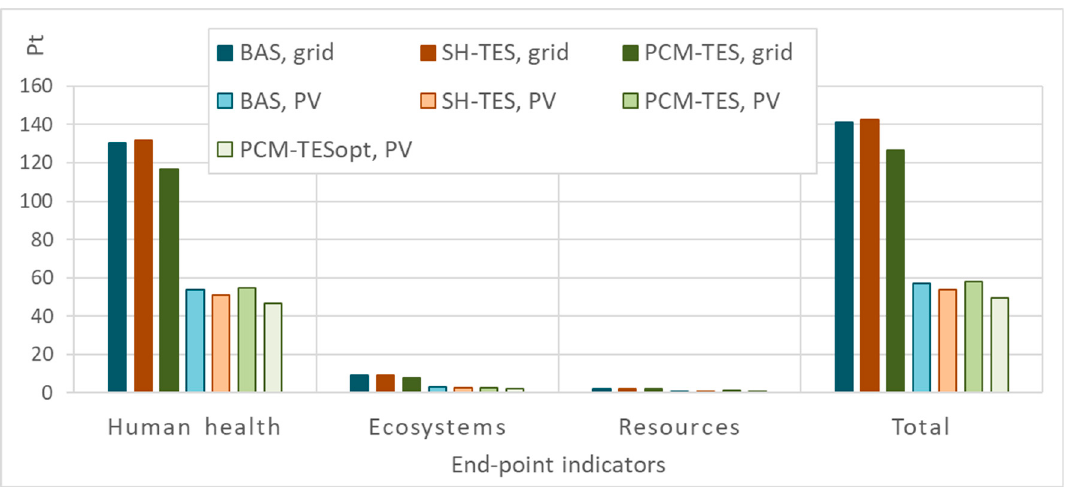
Figure 5. End-point indicator results.